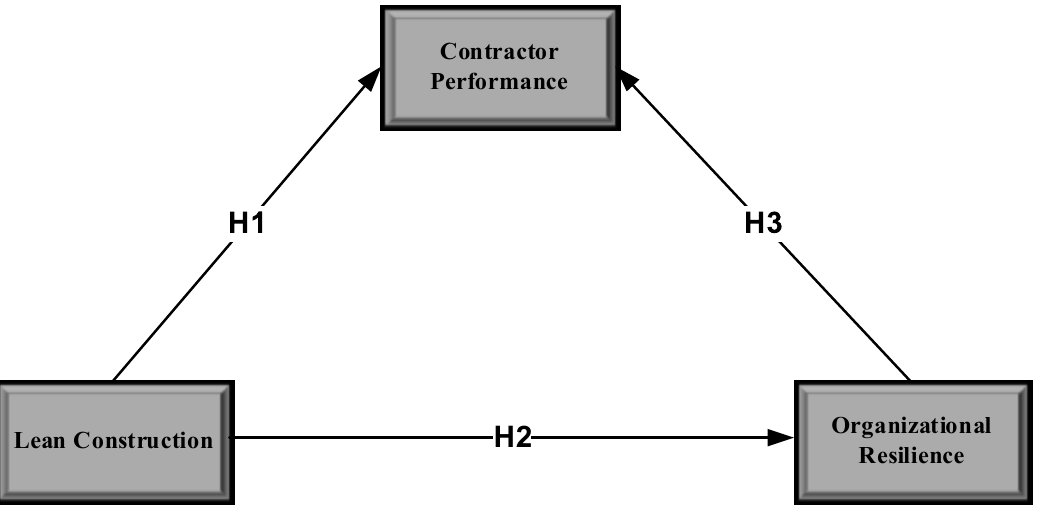
Figure 4. Theoretical framework for operationalization of contributing factors to effectively imple- ment lean construction in infrastructure recovery projects.